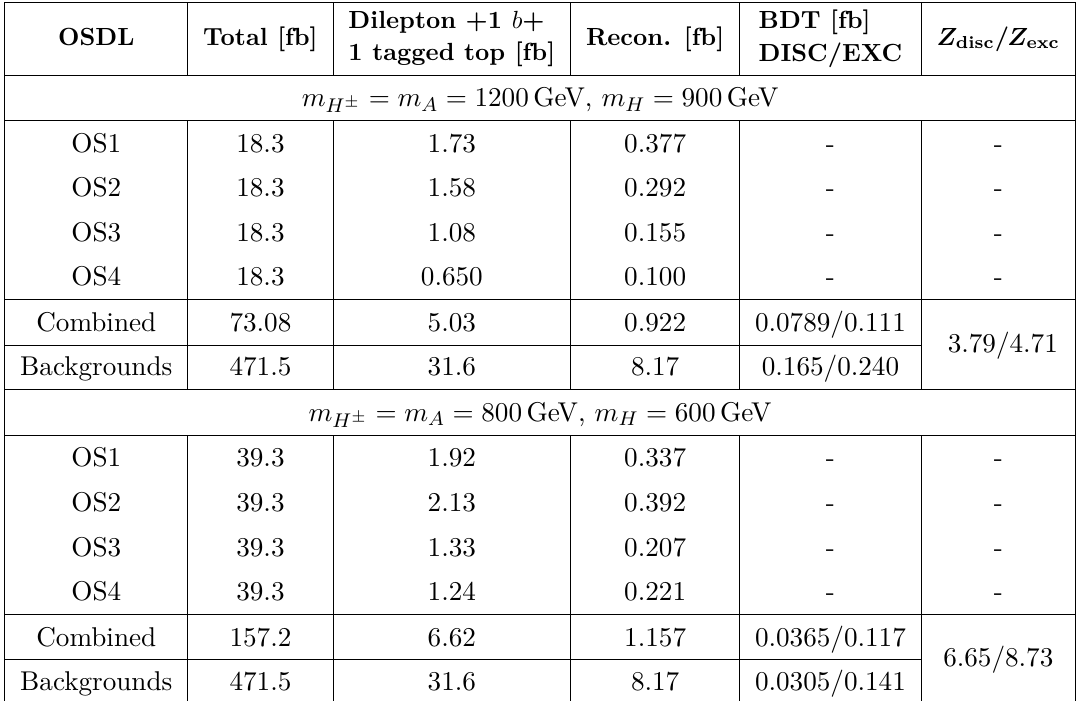
Table 2 . Cross sections of OSDL signal for two benchmark points and dominant SM backgrounds after different steps of cuts. Also shown are the discovery and exclusion significance after BDT cuts for a 100 TeV pp collider with 3000 fb − 1 integrated luminosity.